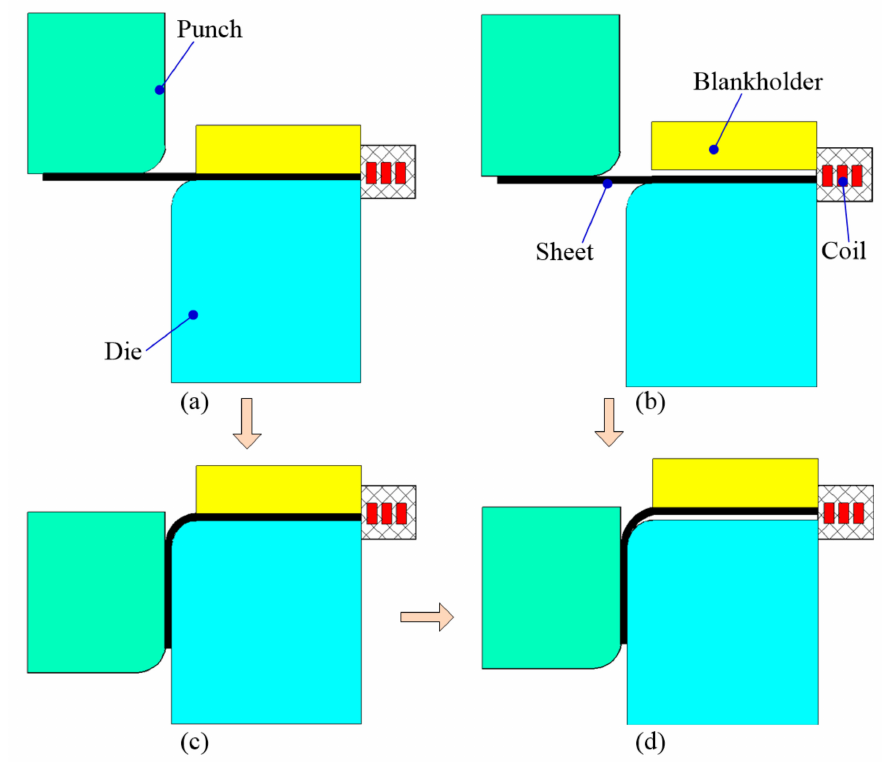
Figure 2. Schematic diagram of the L-shaped part bending and magnetic pulse springback calibration using ( a ) the initial state of forming method 1, ( b ) the initial state of forming method 2, ( c ) the quasi-static stamping of forming method 1, and ( d ) the coil discharge both in forming method 1 and